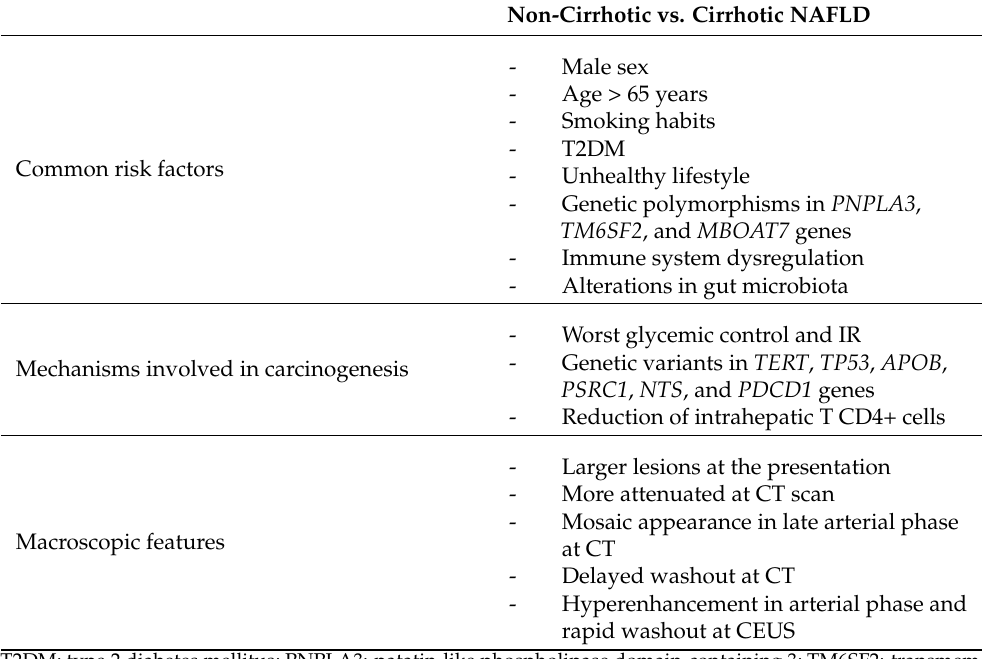
Table 3. Similarities and differences in HCC carcinogenesis between cirrhotic and non-cirrhotic NAFLD